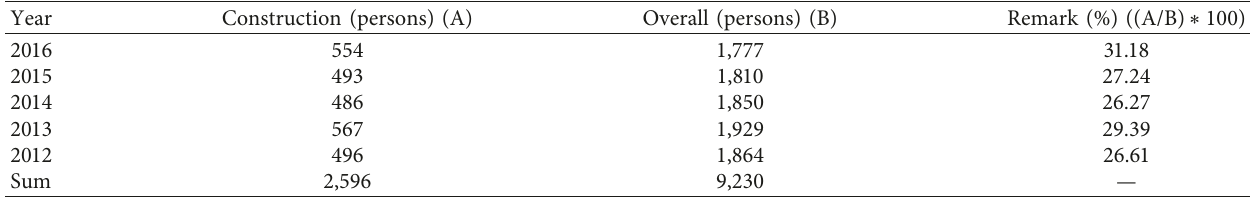
Table 1: Fatal injuries in the Korean construction industry and overall industry.